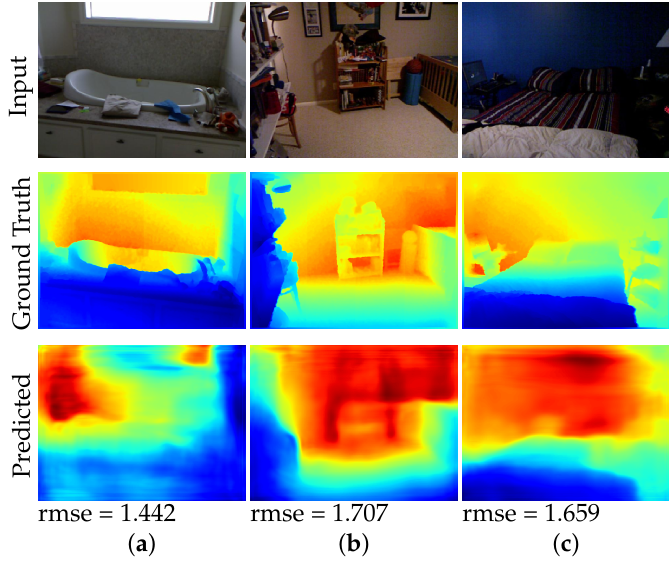
Figure 5. Example failure cases of our